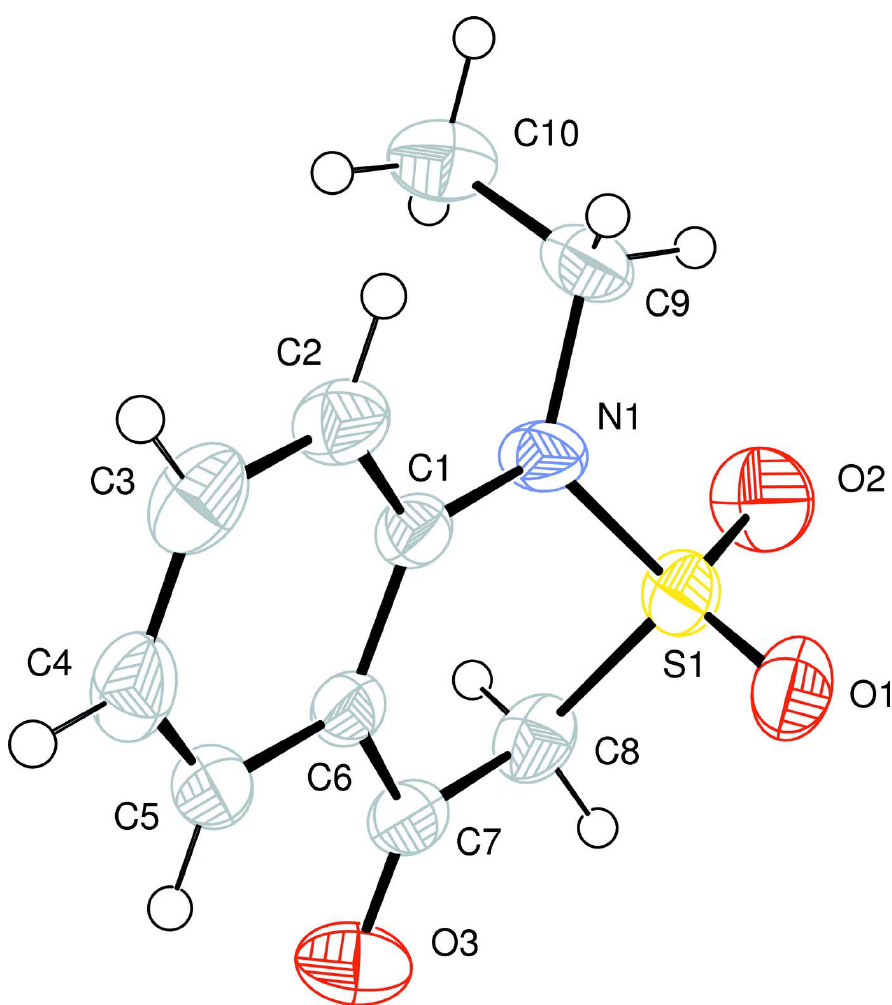
Figure 1 ORTEP - 3 (Farrugia, 1997) drawing of (I) with the atom numbering scheme. The thermal ellipsoids are drawn at the 50% probability